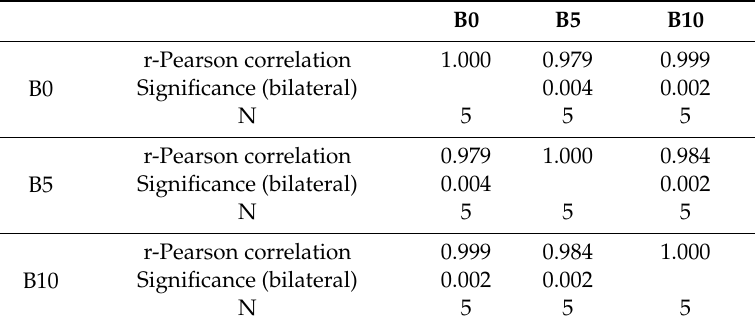
Table 11. Results of r-Pearson correlations